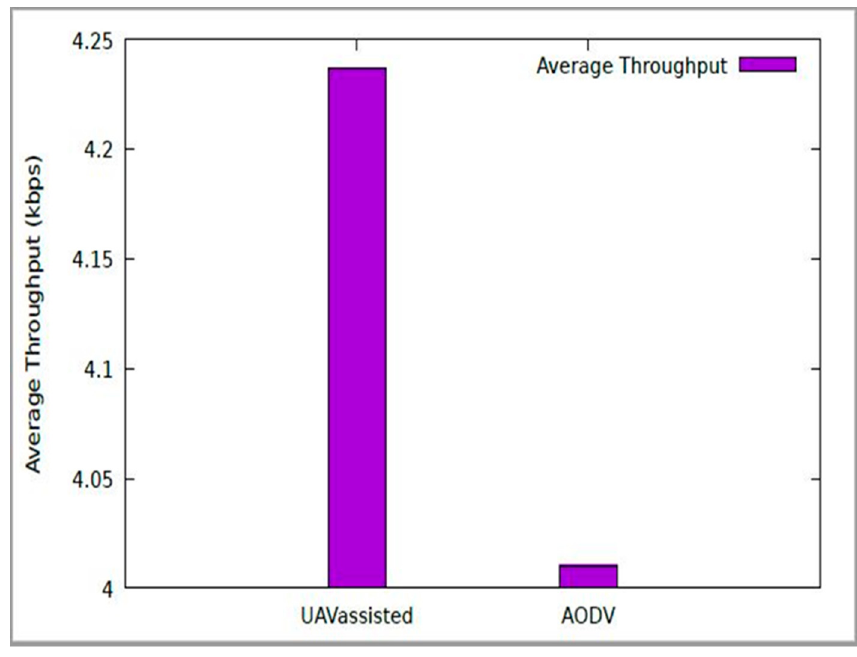
Figure 5. Average throughput.